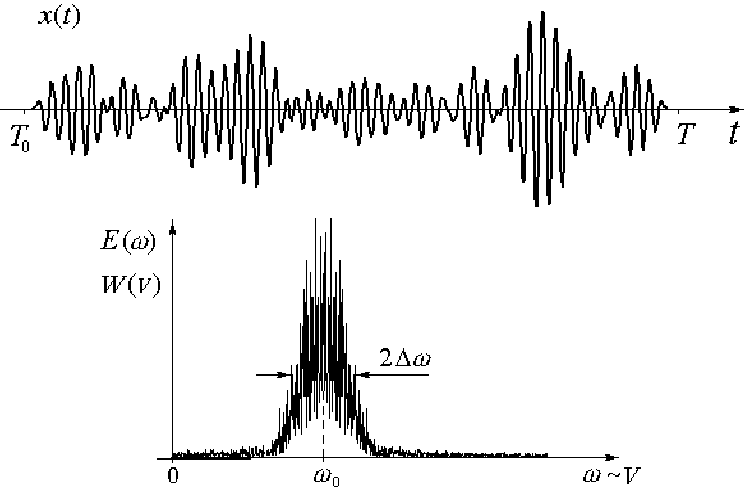
Δω ω of the Doppler signal 0 and